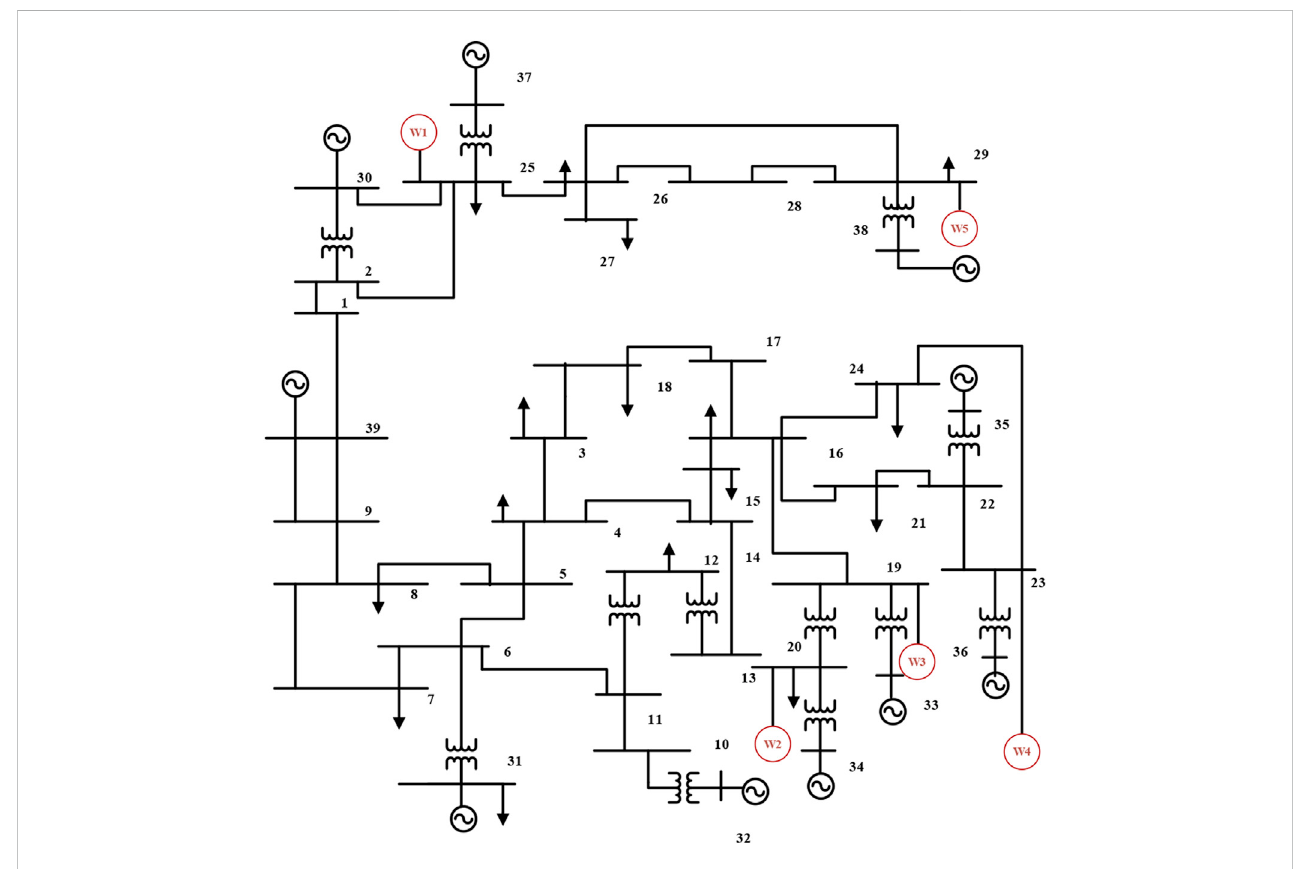
FIGURE 5 Structure Diagram of IEEE-39 bus system with DFIGs.